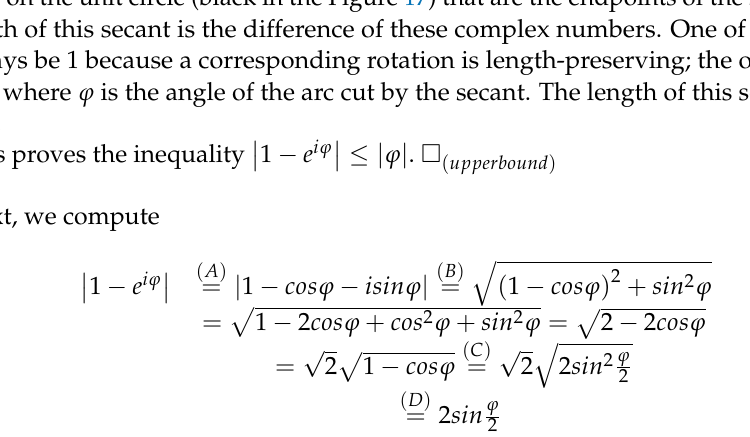
The length of the arc determined by the angle 𝜑 on a circle of radius r is 𝑟𝜑 , i.e., if